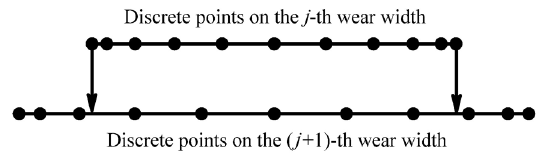
Fig. 6 Variations of the friction coefficients with